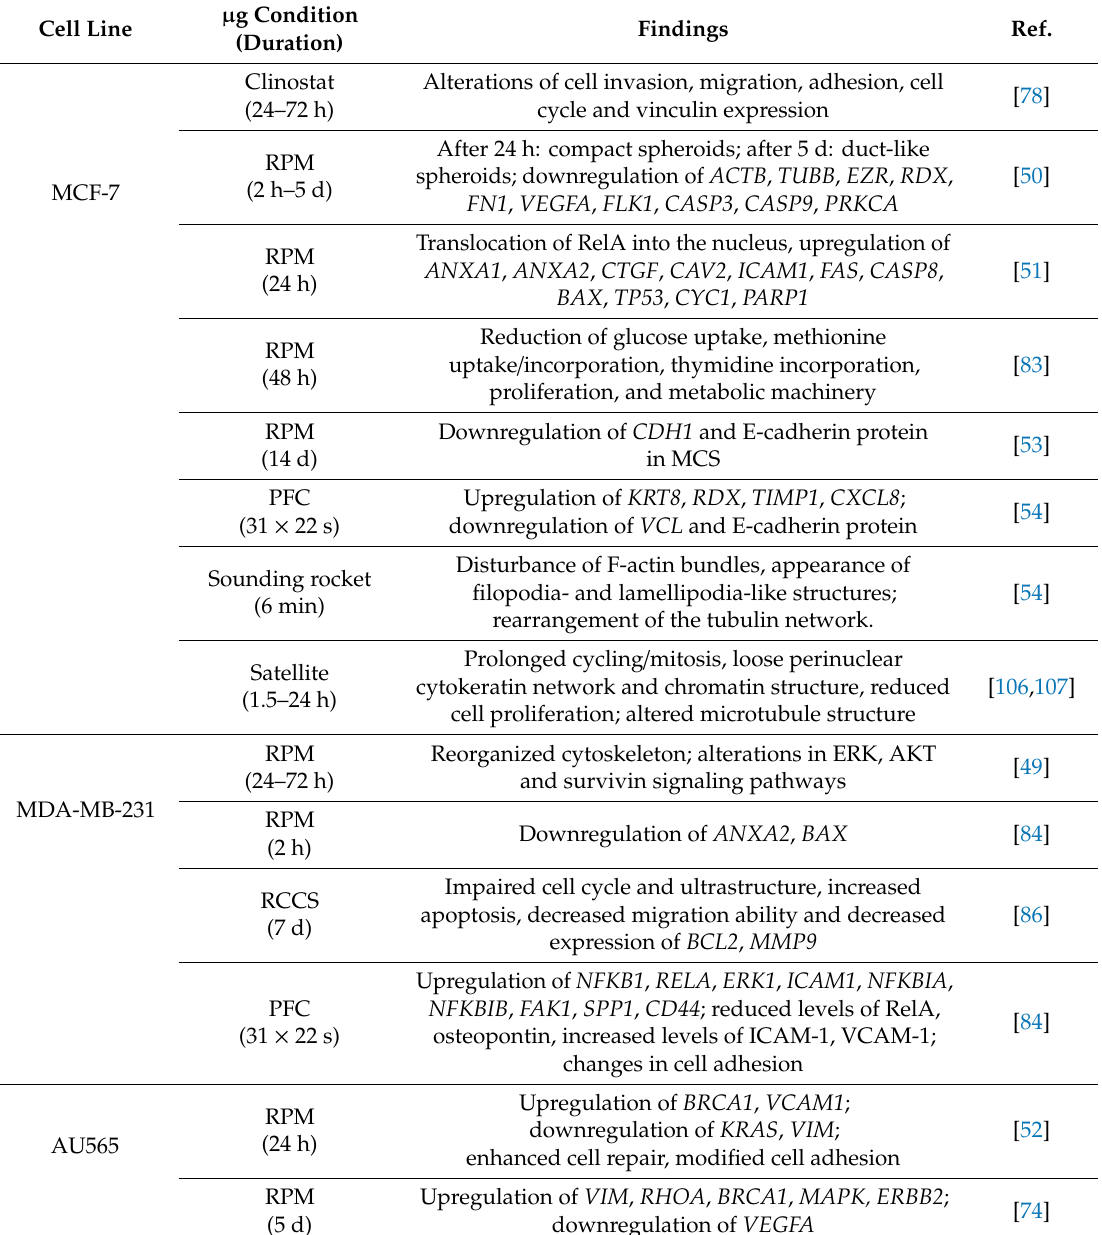
Table 2. Studies reporting the e ff ects of microgravity on human breast cancer